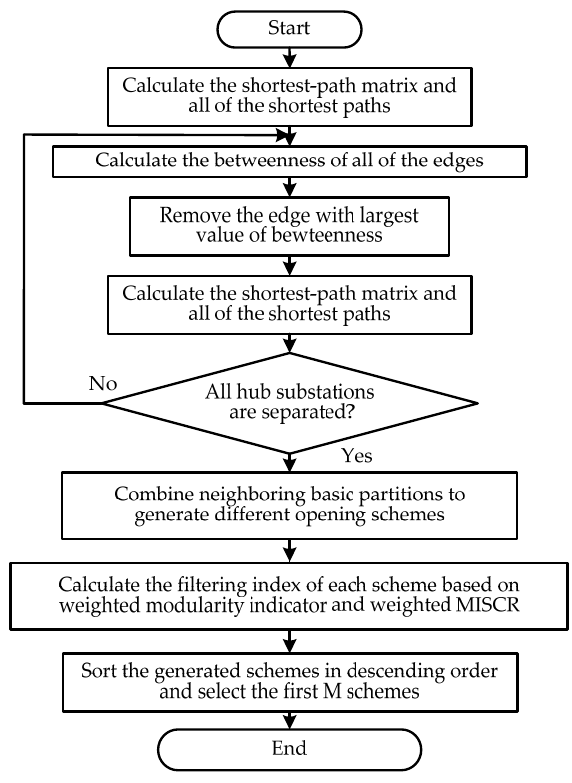
Figure 1. Generation process of parallel loop opening schemes.